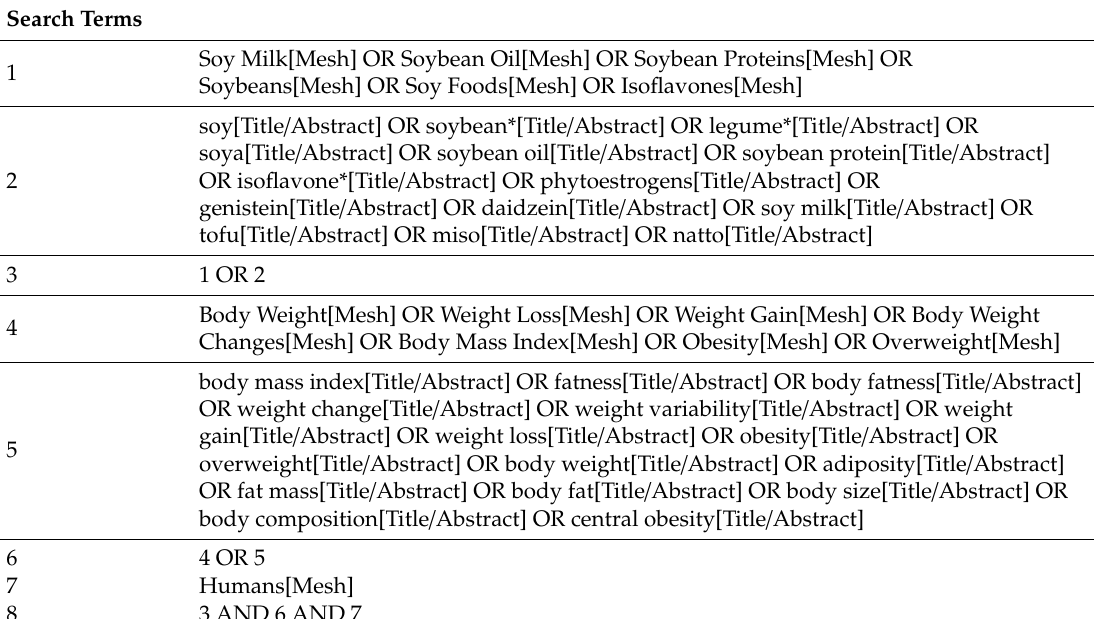
Table 1. The search strategy in PubMed of soy products and